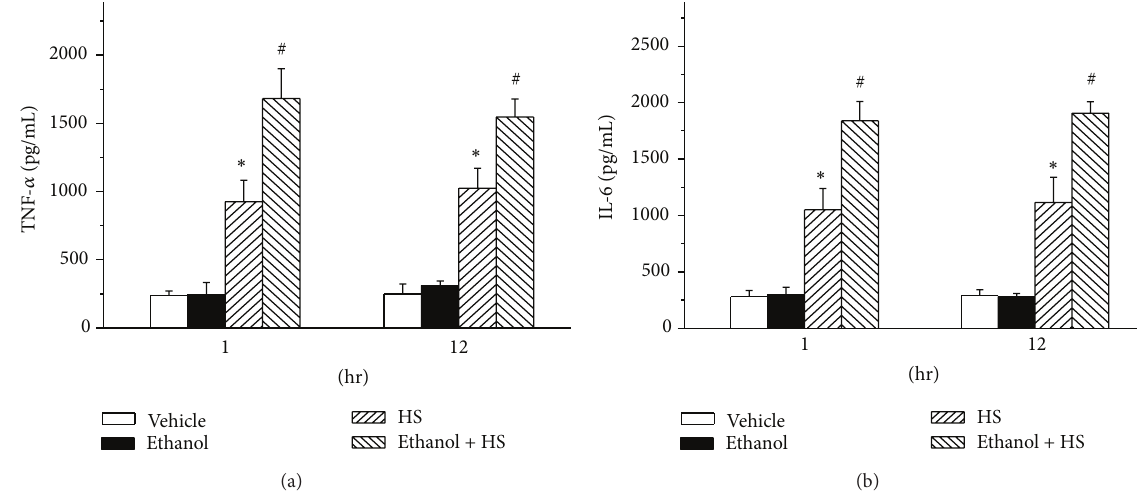
Figure 6: Changes in serum (a) tumor necrosis factor- 𝛼 (TNF- 𝛼 ), and (b) interleukin-6 (IL-6) after hemorrhagic shock in rats. ∗ 𝑃 < 0.05 for the HS group compared with the Vehicle group. # 𝑃 < 0.05 for the Ethanol + HS group compared with the HS group.